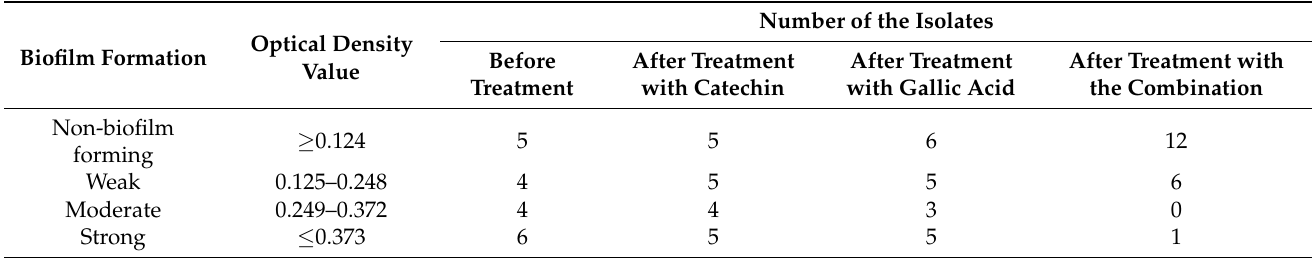
Table 2. Impact of catechin, gallic acid and their combination on the biofilm-forming capability of P. aeruginosa isolates.